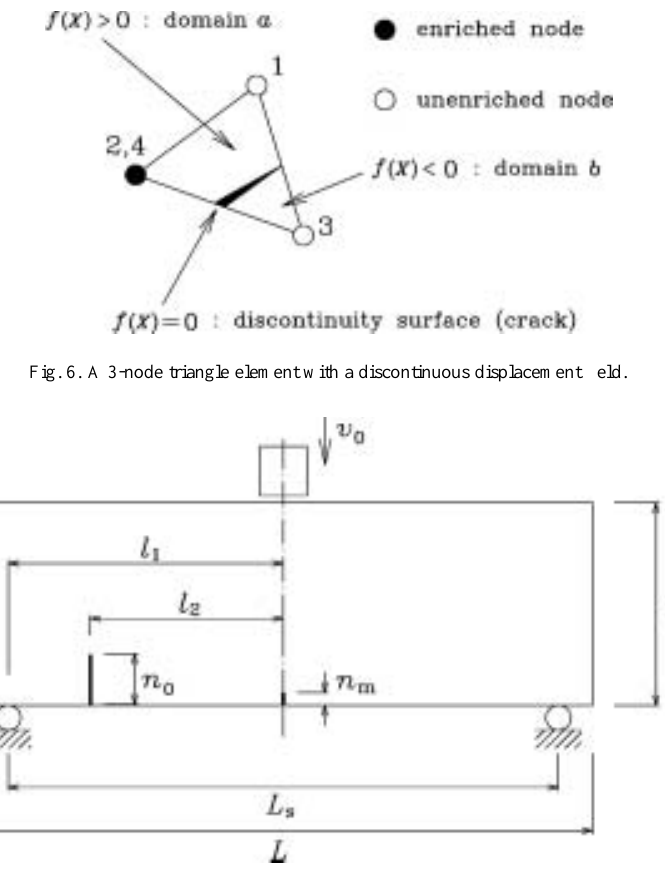
Fig. 7. Concrete three point bending specimen with an offset notch, where h,L,L s ,n 0 ,n m = 76.2, 228.6, 203.2, 19.0, 4.76 mm (3, 9, 8, 0.75, 0.1875 in),